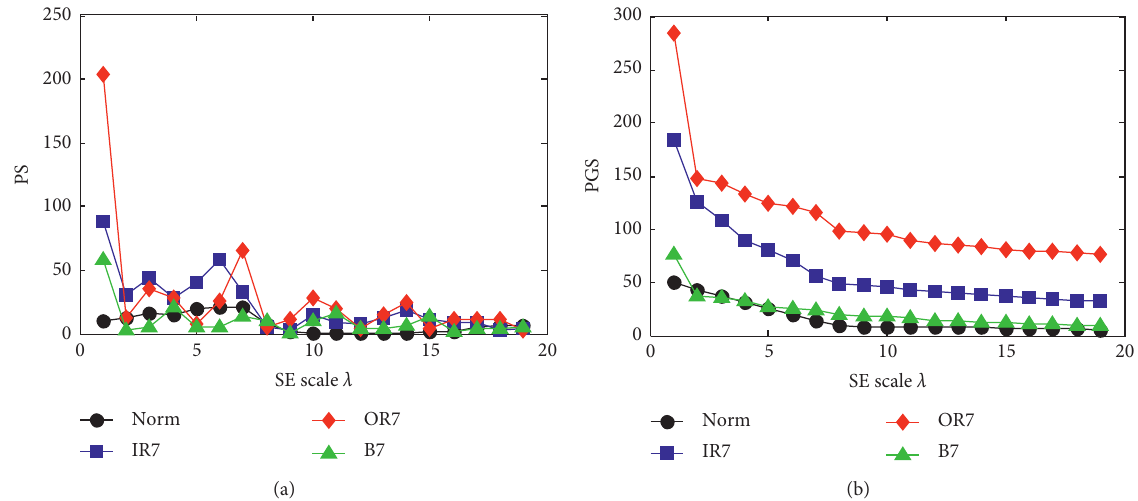
Figure 17: Curves of different bearing vibration signal in case 1. (a) PS and (b) PGS.